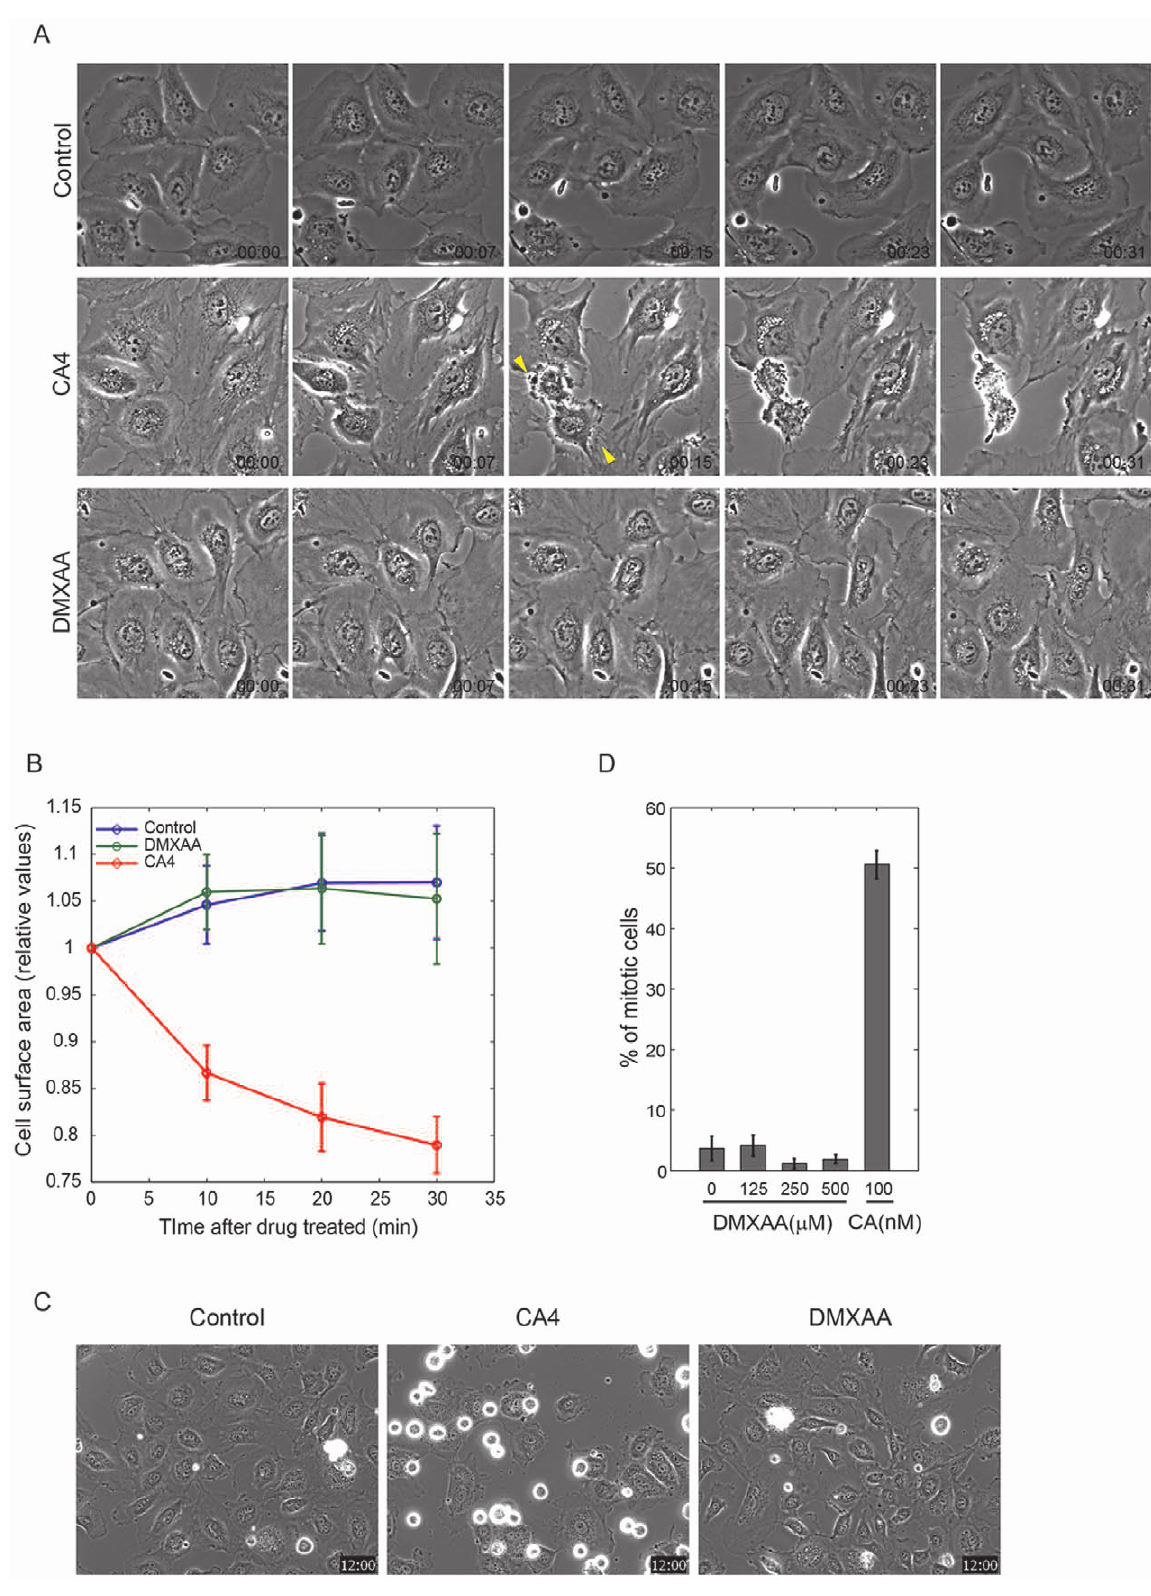
Figure 1. DMXAA does not induce any morphological changes in HUVEC cells whereas CA4 treated cells immediately contract. (A) Images were collected from phase contrast time-lapse movies at indicated times. Original time-lapse imaging was taken every 30 sec for an hour in the presence of 500 m M of DMXAA, 100 nM of CA4 or without drug (control). Elapsed time indicated in hours:minutes. (B) Cell edges were drawn to measure the number of pixels within the cell edges. Individual cell areas were summed to measure total cell surface area at each time point. The total